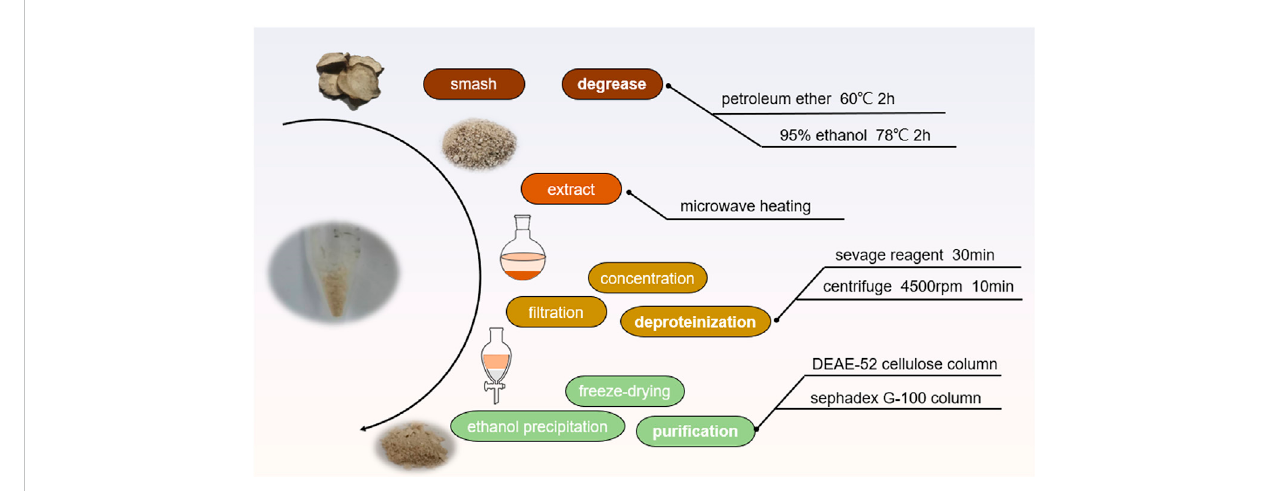
FIGURE 1 Extraction process of